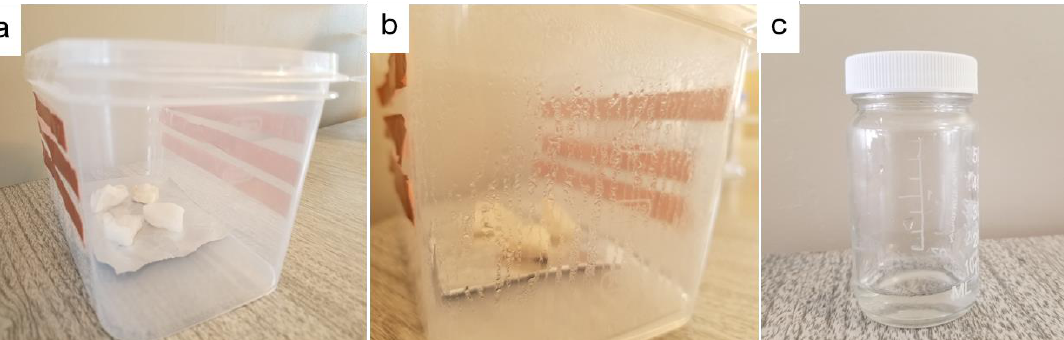
Figure 7. Digital photos of water collection: ( a ) homemade water collection device prototype based on PAN/AM/CaCl 2 hydrogel; ( b ) condensed water on the wall of the box during the water collection process; and ( c ) water collected from a plastic box.